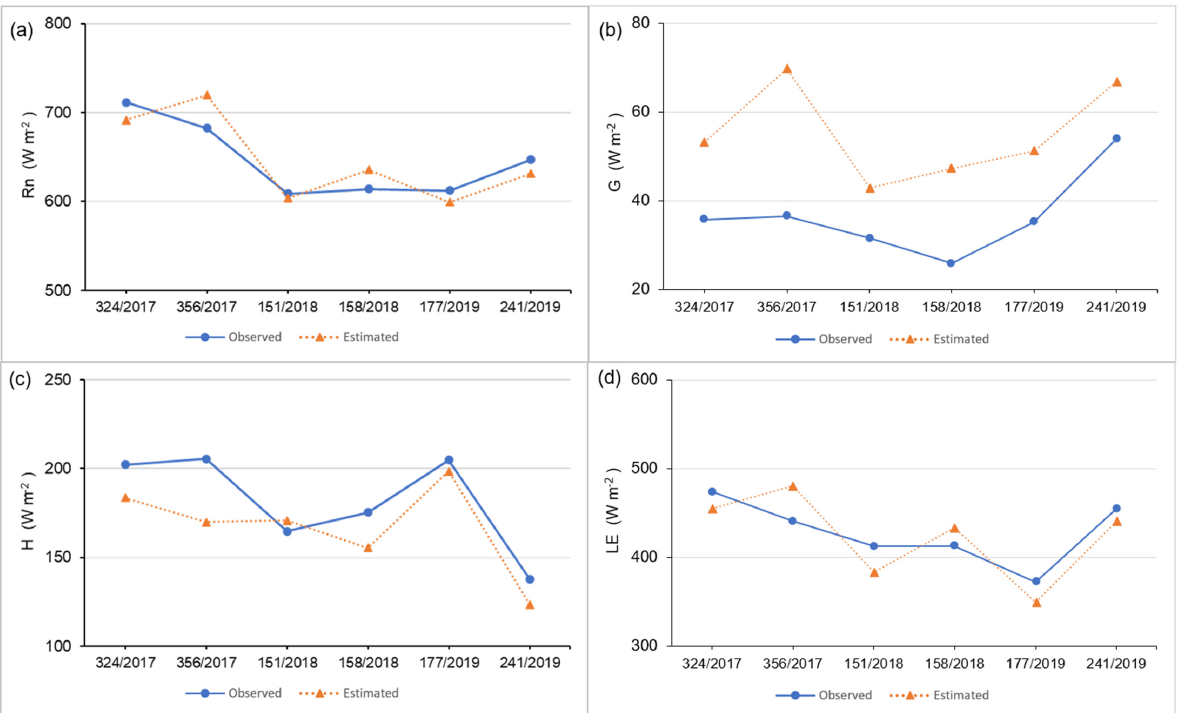
Figure 3. Comparison of the components of the energy balance between the data estimated by SEBAL and observed at the surface: ( a ) radiation balance (Rn); ( b ) heat flow in the soil (G); ( c ) sensitive heat flow (H); and ( d ) latent heat flow (LE).